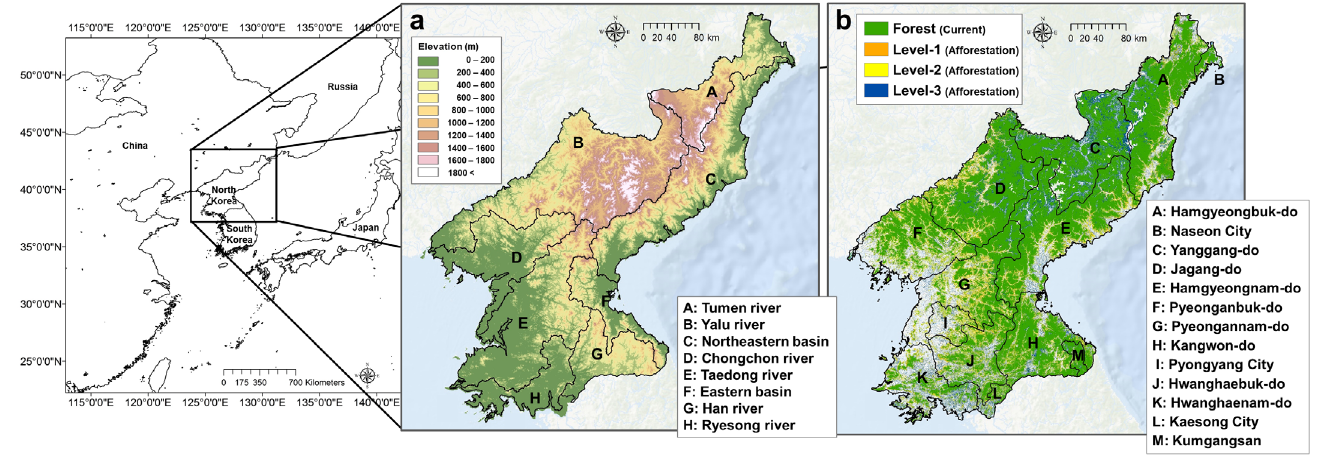
Figure 1. ( a ) Elevation of the study area with the main watershed boundaries and ( b ) forest cover and afforestation levels with administration boundaries.